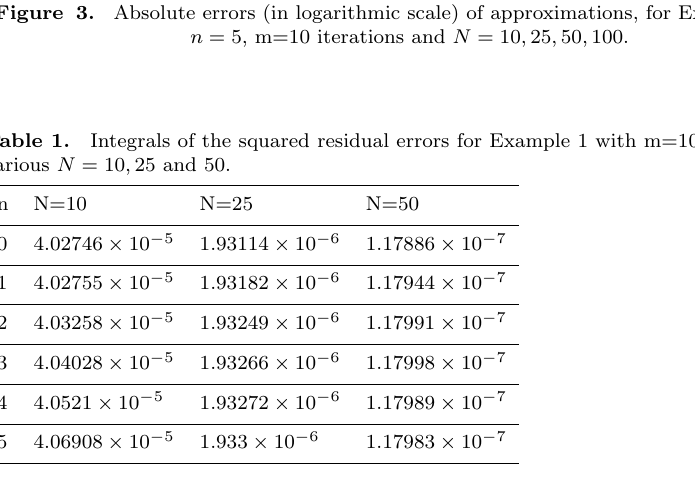
Figure 4 is the graph of Log |C N ( x ) | = Log | R x ( x ) − R N,x ( x ) | for Exam- 10 10 ple 2 with N = 10 , 25 , 50 , 100. The Integrals of the squared residual errors are reported in Table 2 for various h ( y ). Figure 5, shows several of the